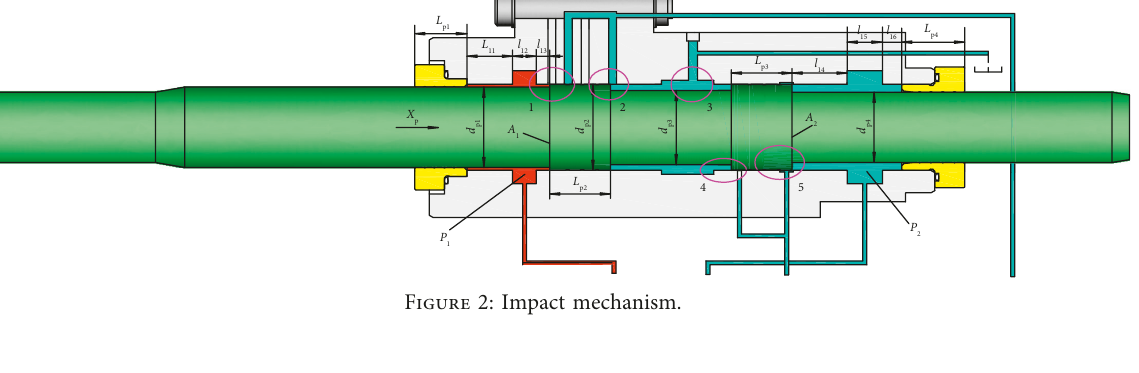
Figure 2: Impact mechanism.